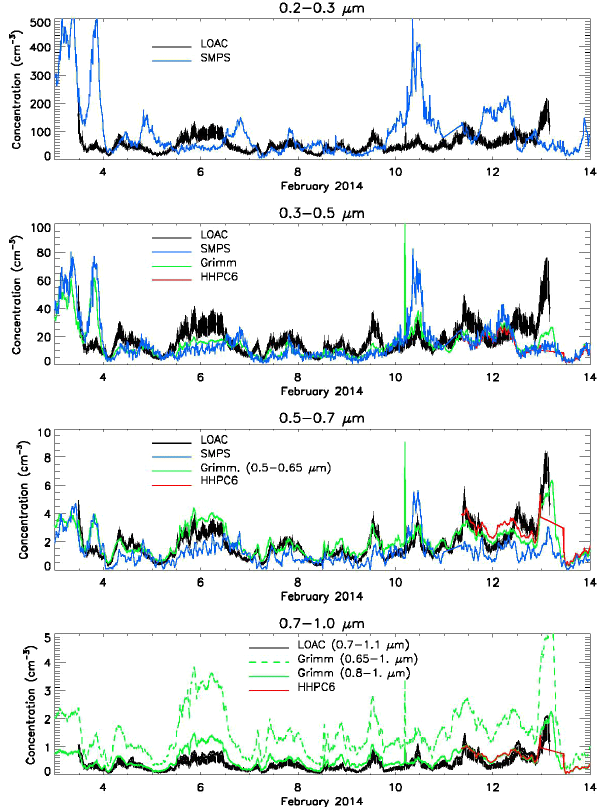
Figure 13. Comparison (in linear scale) between the ambient air measurements obtained during the campaign at the SIRTA-5 station south of Paris.